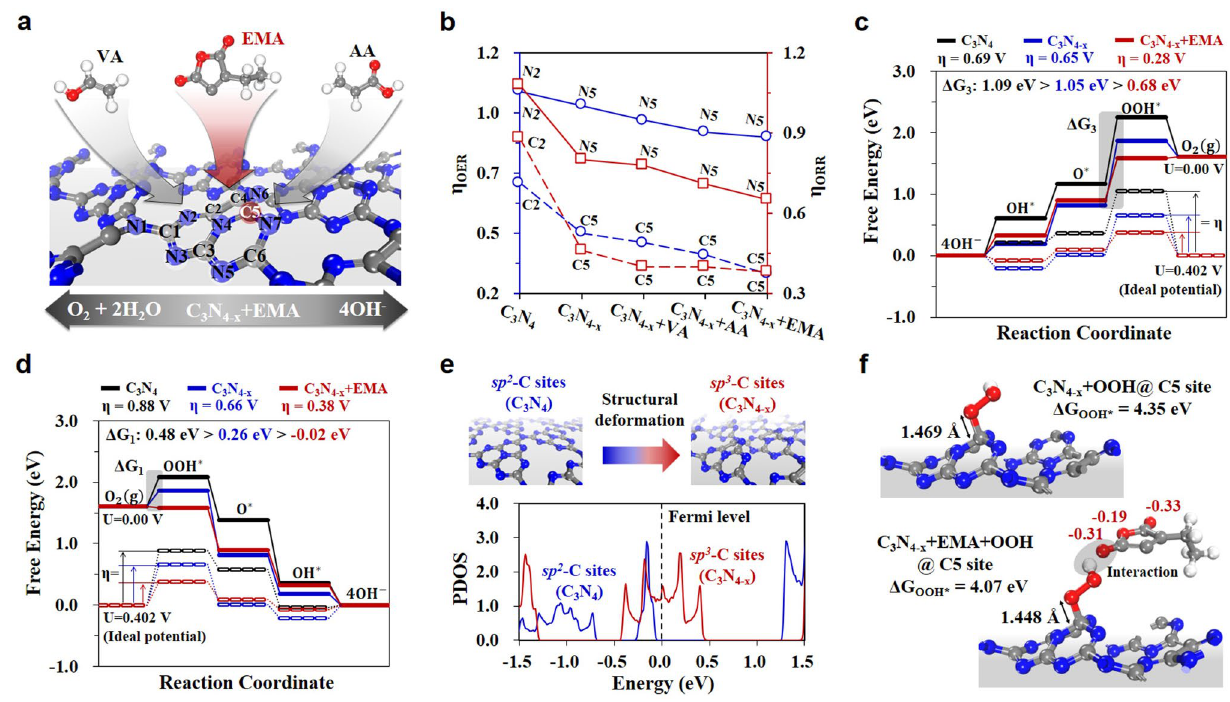
Fig. 7 Theoretical mechanistic evaluations. a OER/ORR bifunctional polymer‑assisted NDCN structures using polymer unit monomer, where VA, AA and EMA represent monomers of poly(vinyl alcohol), poly(acrylic acid) and poly(ethylene‑ alt ‑maleic acid), respectively, and insets indicate active sites with element symbol and Arabic number. b OER and ORR catalytic activity dependency on the active site for N and C of bulk CN, NDCN, PVA@NDCN, PAA@NDCN, and PEMAC@NDCN. Note that the symbol ‘+’ defines the NDCN. Free energy diagrams of c OER and d ORR at U = 0.000 V and U = 0.402 V for bulk CN, NDCN, and PEMAC@NDCN in alkaline media. e Structural deformation induced sp 3 ‑C sites of NDCN and partial density of states (PDOS) of sp 2 ‑C and sp 3 ‑C sites in bulk CN and NDCN, respectively. The Fermi level is indicated by a black dashed line. f The optimized structures of NDCN and PEMAC@NDCN with OOH* intermediate at the C5 active